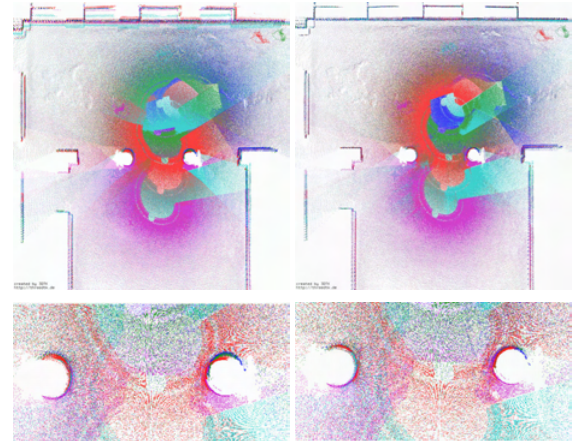
Figure 8: Example of calibrating the robot Irma3D in the field (Ostia Antica, cf. Fig. 1. Left: Before calibration. Right: After calibration.